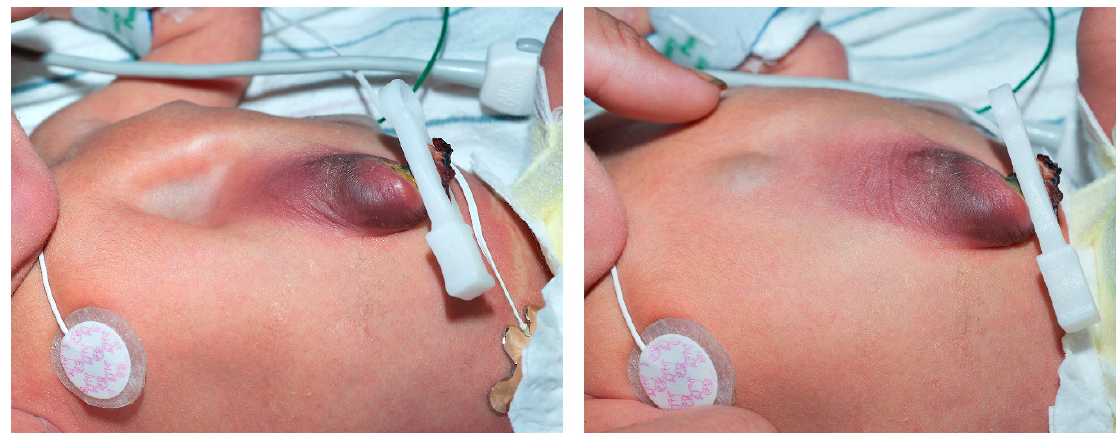
Figure 3. Photograph during inspiration and exhalation revealing ectopic cordis and minor omphalocele.